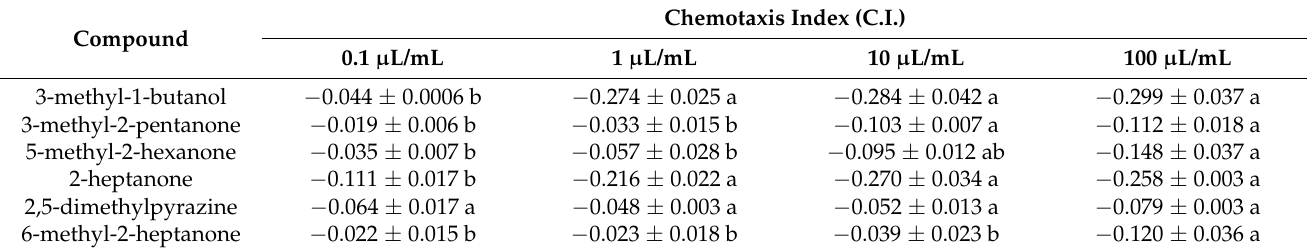
Table 3. Chemotaxis index values of commercial VOCs toward M. hapla . Different lowercase letters indicate significant differences among different concentrations of the same VOC. ( n =